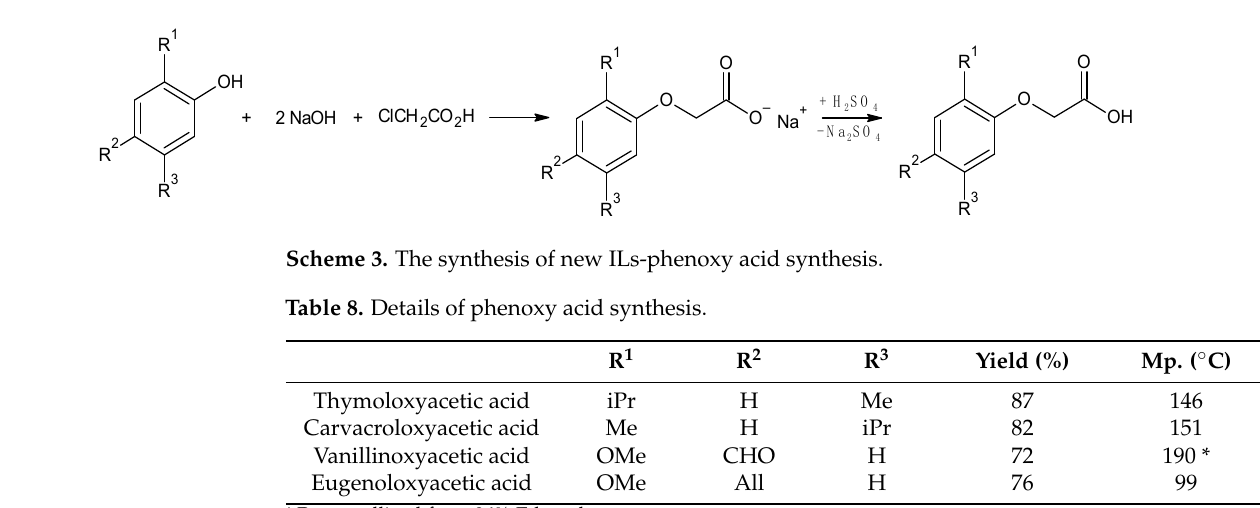
12 of 17 Scheme 2. The synthesis of new ILs, neutralization process of 1-methyl-3-octyloxymethylimidazo- lium hydroxide. Next, water was removed using a rotary evaporator, and the obtained product was thoroughly dried under reduced pressure (5 mbar) at 60 °C for 10 h. All synthesized ILs were stored under reduced pressure over P4O10. The yield of neutralization reaction was 99.5%. Phenoxy Acid Synthesis A phenol compound (thymol, carvacrol, eugenol, vanilin) dissolved in warm water was added to a solution of sodium hydroxide (2.1 eq.) in warm water. After mixing for 30 min at 50 °C, monochloroacetic acid (2.1 eq.) was added. The obtained solution was mixed overnight at 50 °C. After cooling to room temperature, the solution was acidified to pH 2 with 10% sulfuric acid. The obtained solid phenoxy acetic acid was separated with a Buch- ner funnel. Water from the aqueous phase was removed on a rotary evaporator, and the